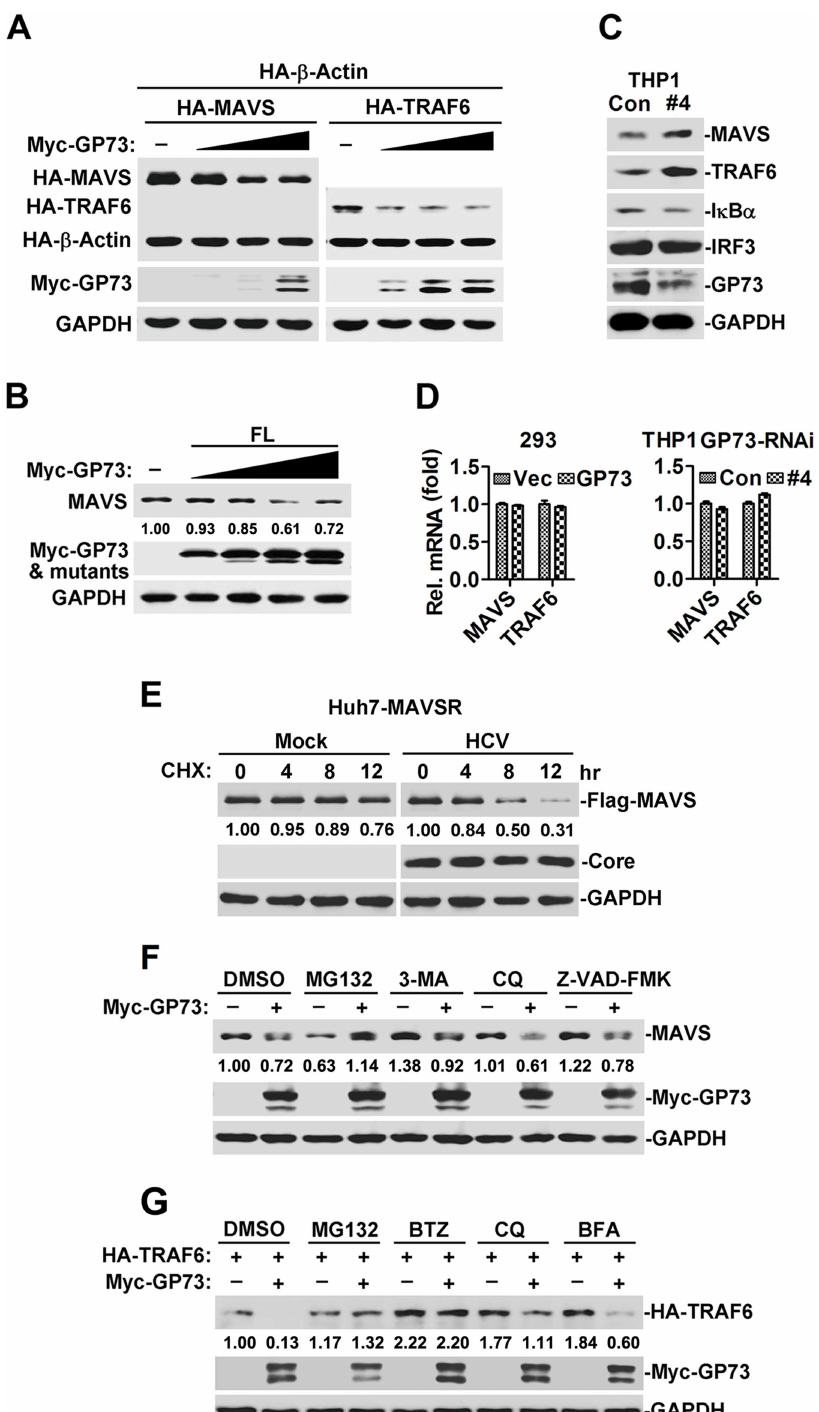
Fig 5. GP73facilitatesproteasome-dependent degradation of MAVS and TRAF6. ( A )HEK293cells (2 × 10 5 ) wereco-transfected with GP73 plasmidsat 0, 0.125, 0.25 or 0.5 μ gand β -actin plasmid(0.05 μ g)along with MAVS or TRAF6 plasmids(0.5 μ g)for 24 h. WCLs weresubjected to WB with indicatedantibodies.( B ) HEK293cells(5 × 10 5 ) wereco-transfected with GP73 plasmidsat 0, 0.5, 1, 1.5 or 2 μ gfor 24 h. Endogenous MAVS was determinedby WB. ( C )THP-1-GP73-RNAicellswerecollectedandendogenousMAVS, TRAF6, IRF3 andI κ B α proteinsweredetectedby WB. ( D )HEK293cells(5 × 10 5 ) weretransfectedwith controlor